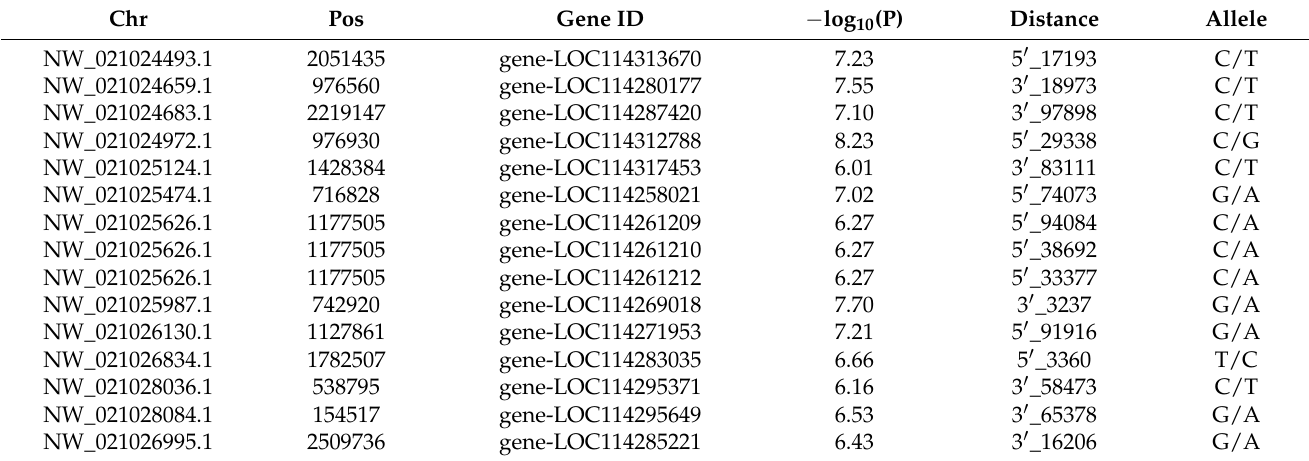
Figure 7. Manhattan plot ( a ) and quantile–quantile plot ( b ) for tree shape of 125 ancient plants. The abscissa represents scaffold position, and the ordinate represents p-value ( − log 10 (P)), with a negative logarithm (base 10). Scattered points (or lines) on the graph represent the −log 10 (P) corresponding to each SNP loci. The green horizontal dashed line corresponds to −log 10 (P) = 5, the red horizontal dashed line corresponds to −log 10 (P) = 7, and the blue horizontal dashed line corresponds to −log 10 ( P ) =7.5. Red arrows indicate candidate gene loci obtained by screening, and blue arrows show the significant association signal peaks. Table 4. Strong association signal sites and annotation information of tree shape